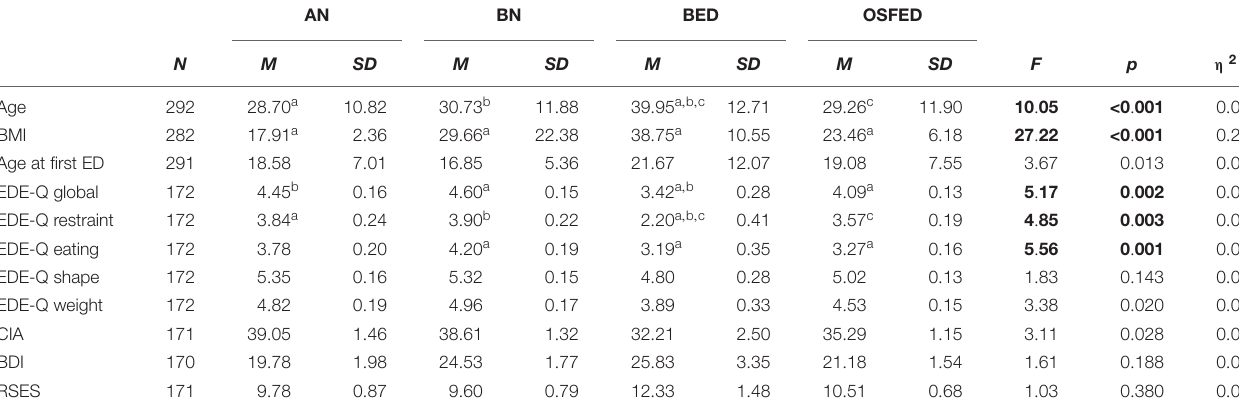
TABLE 1 | Descriptive characteristics and symptoms across diagnostic group at treatment intake.